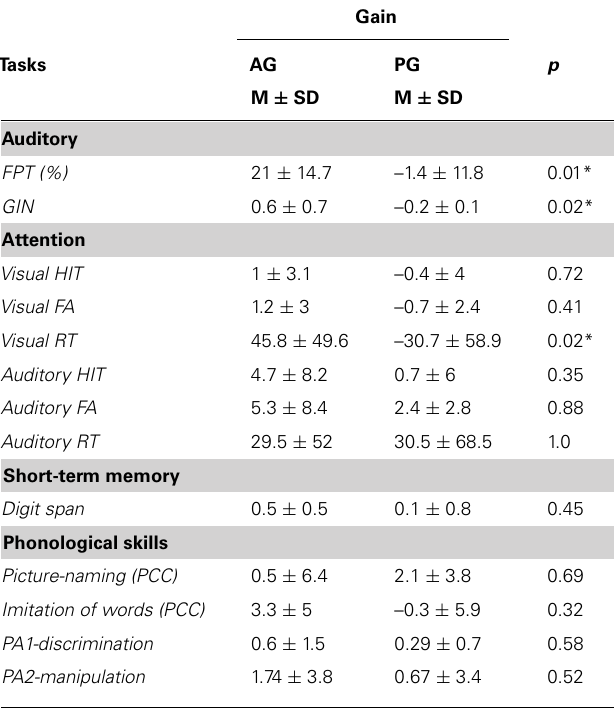
Table 3 | Comparison between gains in both groups (Inter-group